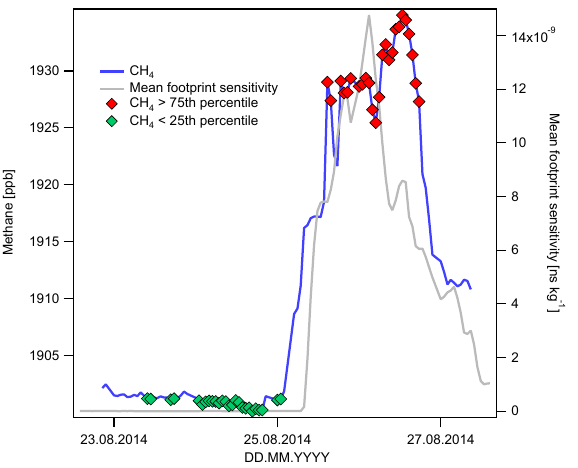
Figure 9. The methane (CH 4 ) atmospheric mixing ratio observed at the Helmer Hanssen north of Svalbard and mean footprint sen- sitivity to the active sub-sea seep region described by Geissler et al. (2016), from 80.39–81.11 ◦ N, 13.83–19 ◦ E (see also Fig. 8c), total area 3582.43km 2 . Points used to estimate a flux, i.e. the high- est CH 4 mixing ratios (above the 75th percentile) are shown in red and points corresponding to the lowest CH 4 mixing ratios (be- low the 25th percentile) are shown in green. Mean sensitivity to this area was determined using bilinear interpolation of the original 0.5 ◦ × 0.5 ◦ FLEXPART footprint sensitivity